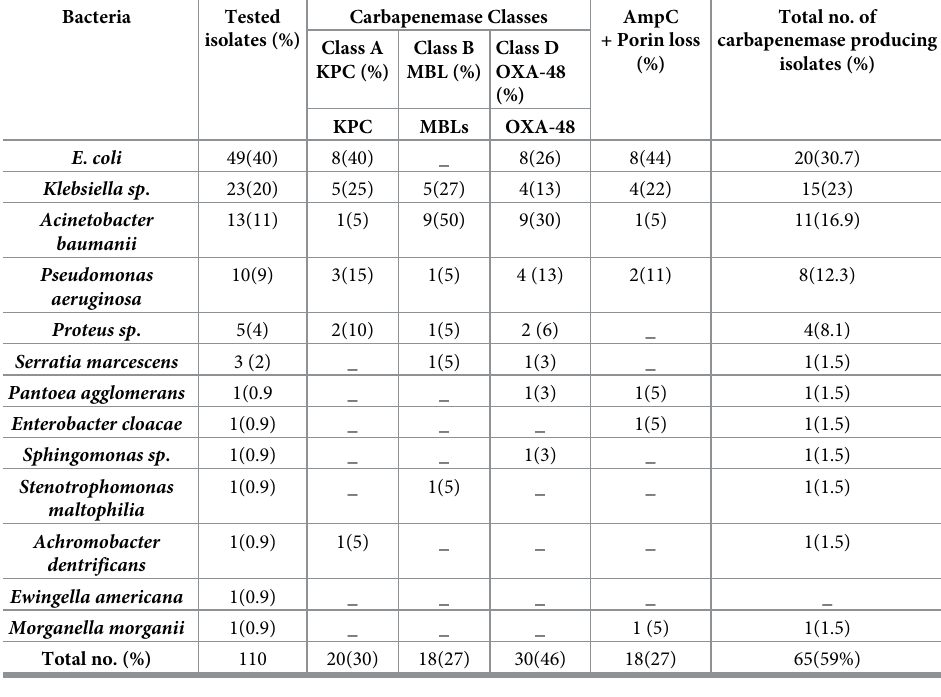
Table 4. Phenotype detection of carbapenemase-producing isolates of Gram-negative bacilli. Bacteria Tested Carbapenemase Classes AmpC isolates (%) + Porin